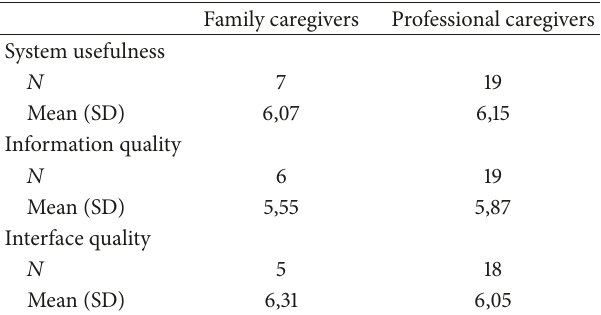
Table 3: Mean scores ∗ of family and professional caregivers per subscale of the